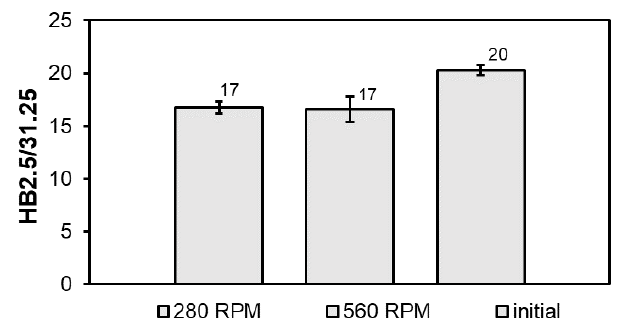
Figure 8. Comparison of hardness of B89 alloy before and after FSP.